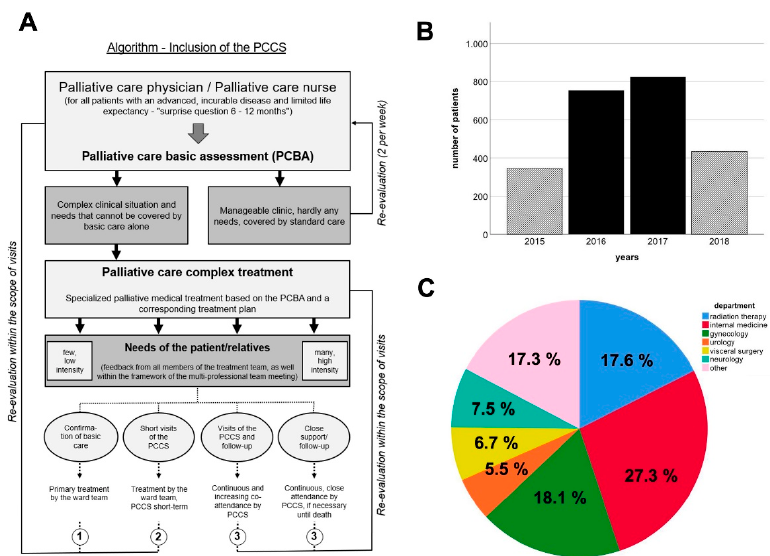
Figure 1. Algorithm of palliative care consultation service (PCCS) inclusion and analysis of patient number development as well as departmental allocation. Algorithm detailing how to match PCCS and a patient‘s situative need for palliative care ( A ). Patient number dynamics over the entire period of study ( B ). Pie chart comparing the amounts of patients referred to the PCCS by respective departments ( C ). “Other” includes nuclear medicine, cardiac surgery, neurosurgery, ophthalmology, vascular surgery, orthopedics, psychiatry, trauma surgery, dermatology, head and neck surgery, anesthesiology and ear, nose and throat